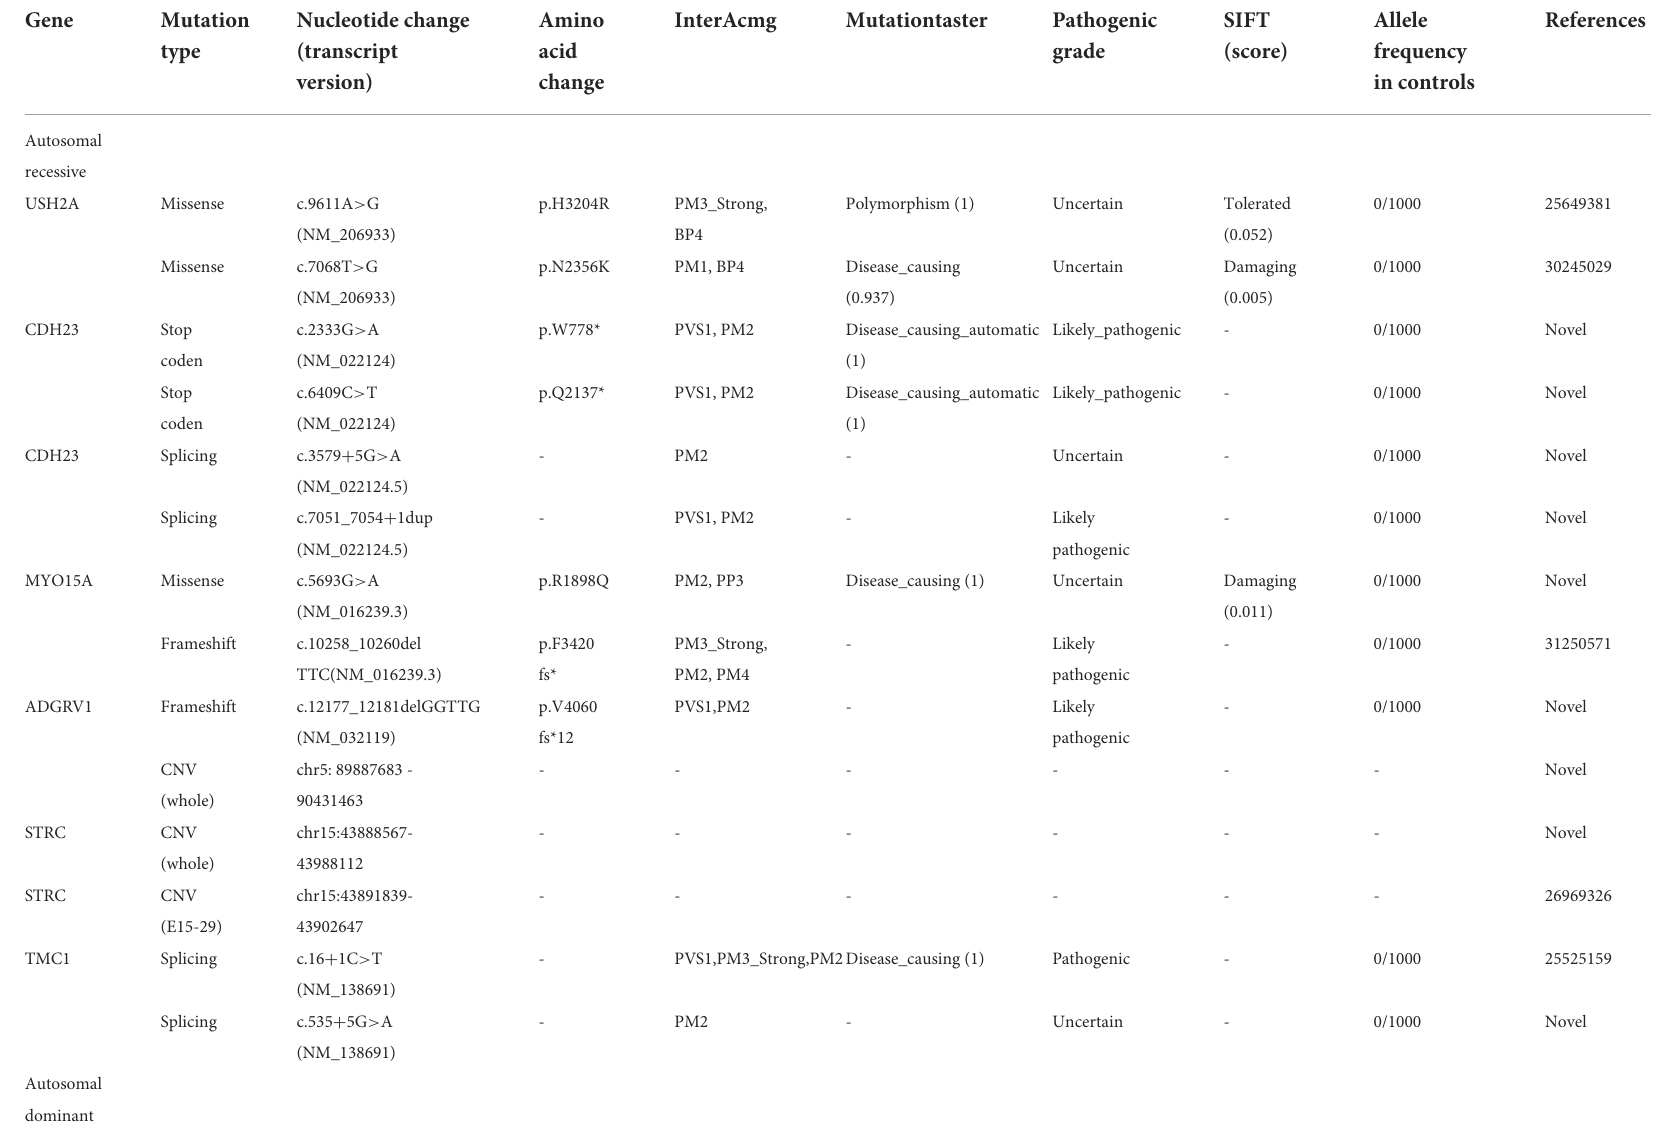
TABLE 1 The gene mutation of